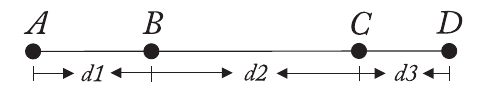
Figure 4. The 2D model design features projective invariant